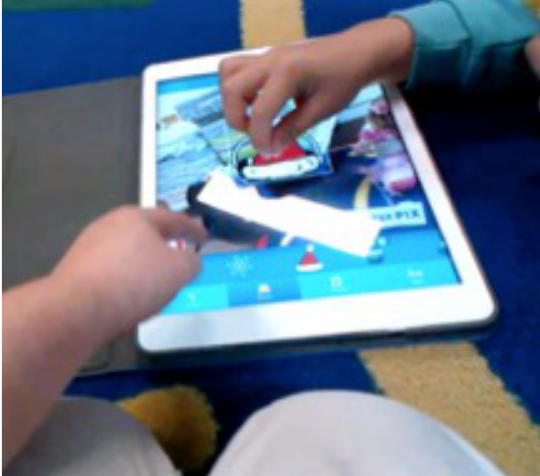
Figure 9. Participants 2 and 5 move out of researcher camera shot